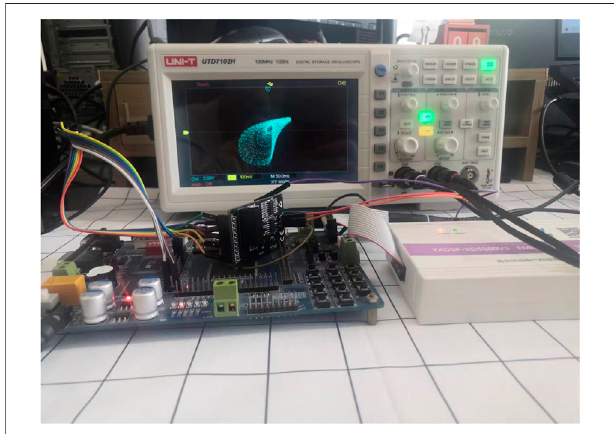
FIGURE 16 | Experimental platform for DSP